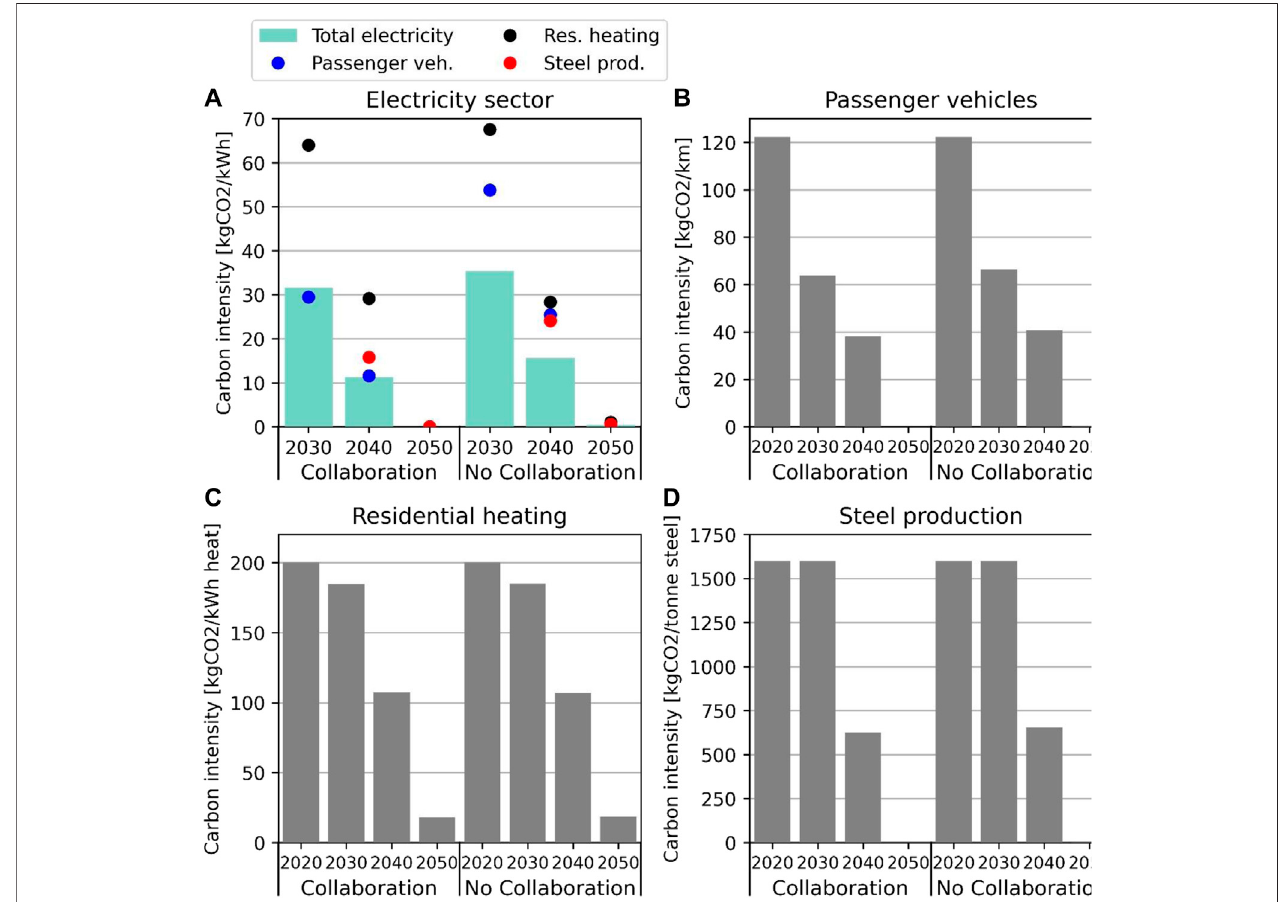
FIGURE 6 | Total carbon dioxide emissions intensities of: (A) the electricity system and electri fi ed sectors (industry, transport, and heat sector); (B) the transport sector, in gCO 2 /km; (C) the heat sector, in gCO 2 /kWh heat ; (D) the industry sector, in kgCO 2 /tonne steel, for different scenarios and